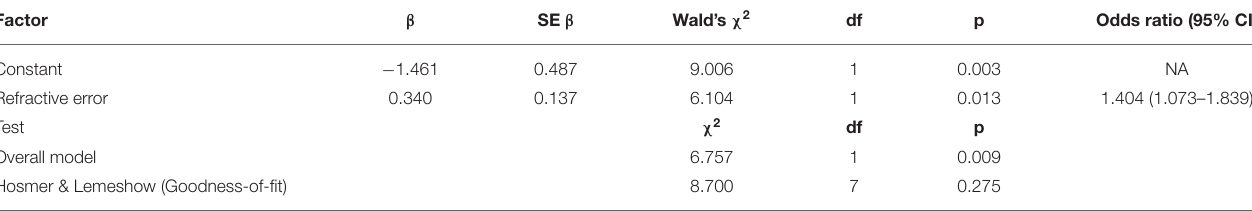
TABLE 2 | Outcome of logistic